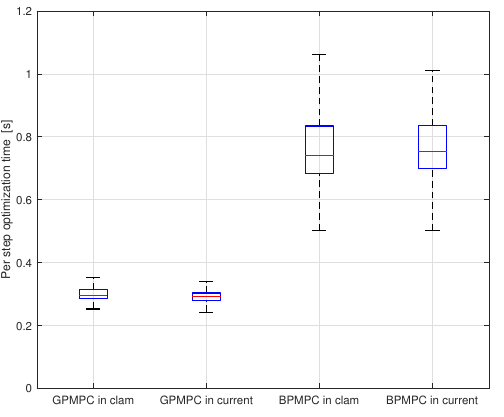
Figure 25. Single step optimization time statistics of GPMPC and BPMPC under different conditions (box